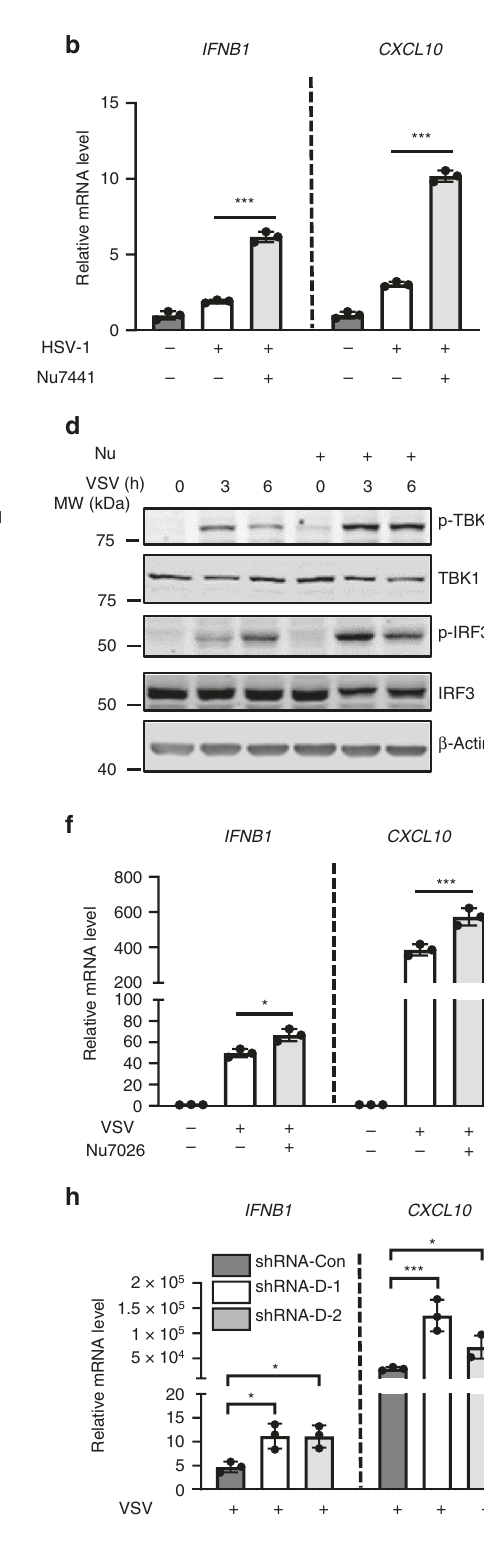
antiviral innate